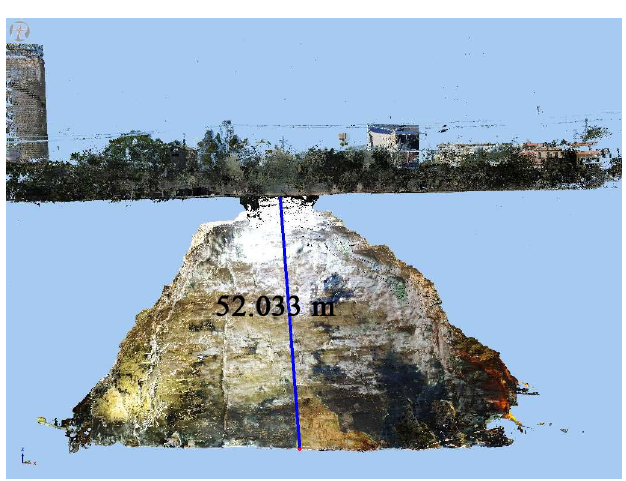
Figure 10. Real numerical model of the point cloud. The blue vertical line provides the height of the cavern.